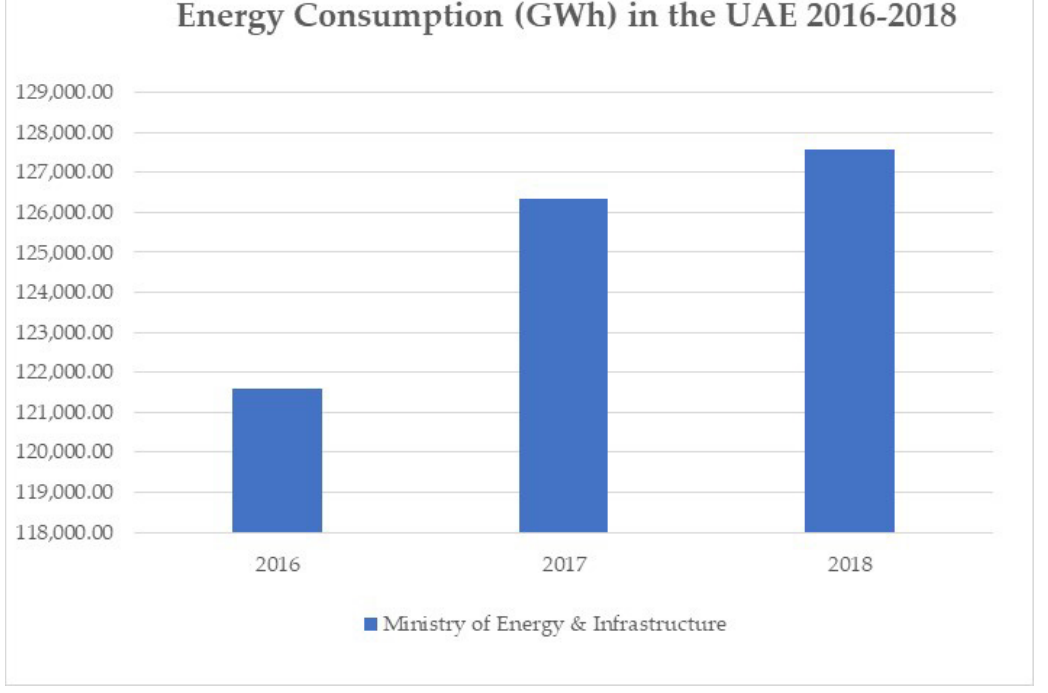
Figure 3. Energy consumption in gigawatt hours (GWh) in the UAE between 2016 and 2018. Source: [8].